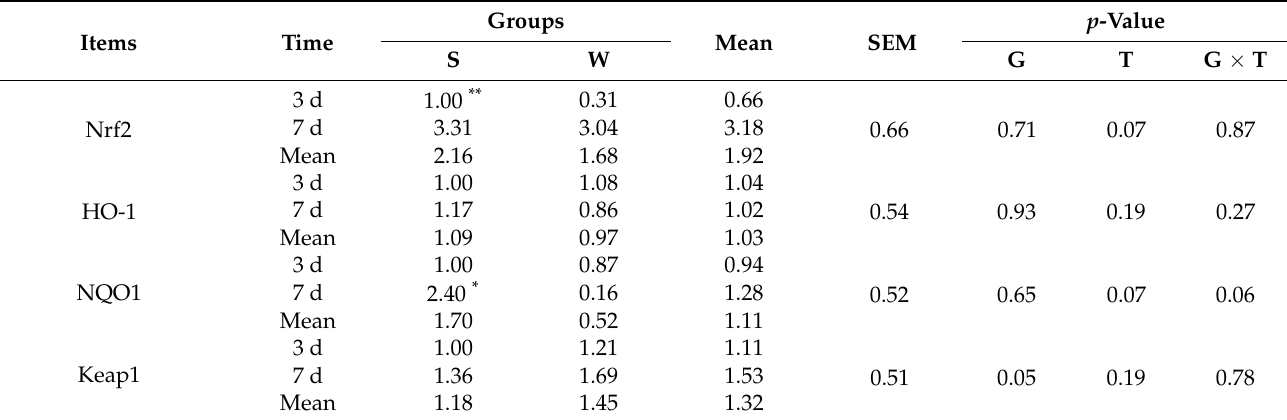
Table 7. Effects of weaning on gene expression of Nrf2 pathways in the liver of